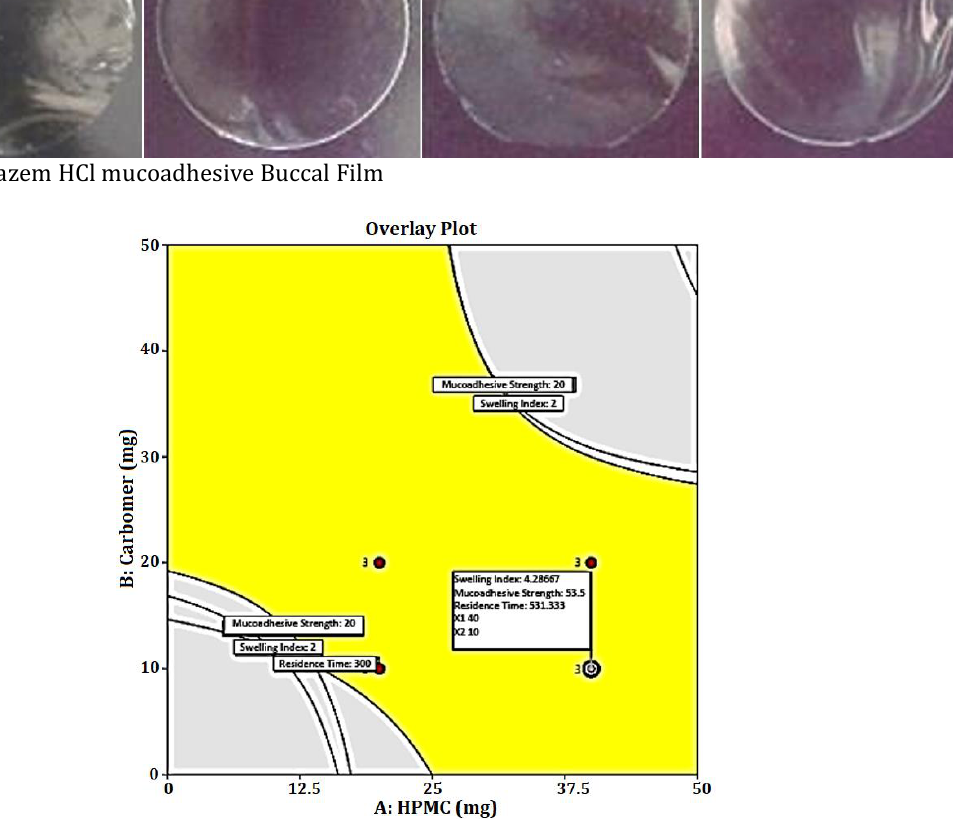
Figure 3. Overlay Plot of Three Responses (shown in Yellow) Table II. Physical evaluation of Diltiazem HCl mucoadhesive buccal films Film weight (mg) Film thickness (cm) Folding